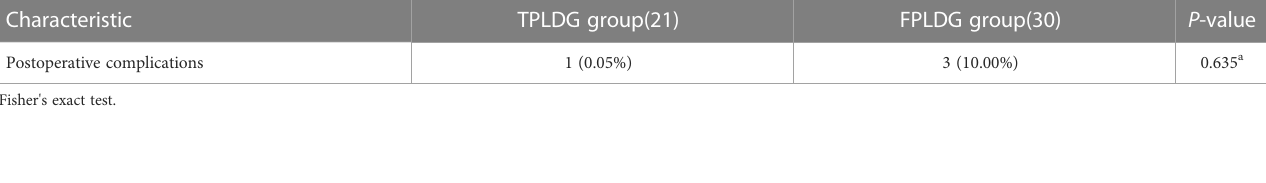
TABLE 3 Comparison of intraoperative conditions between the TPLDG and FPLDG groups.